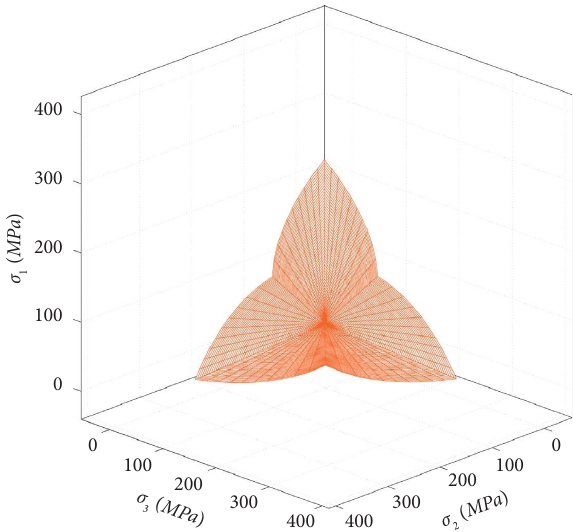
Figure 3: Mogi–Coulomb failure criterion in the principal stress space.